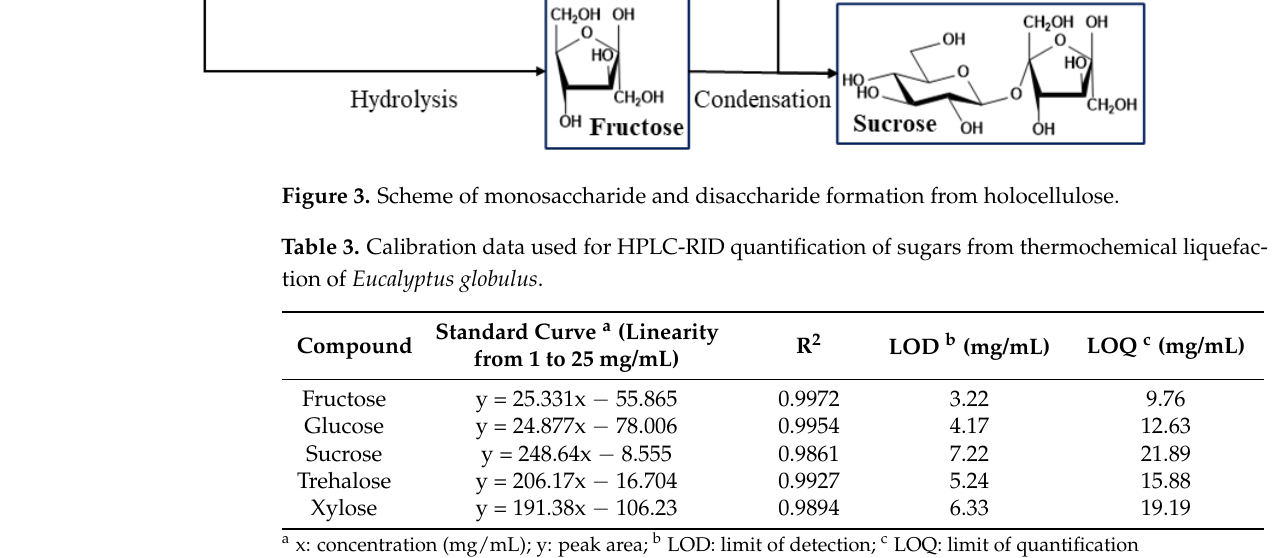
Table 3. Calibration data used for HPLC-RID quantification of sugars from thermochemical lique- faction of Eucalyptus globulus .